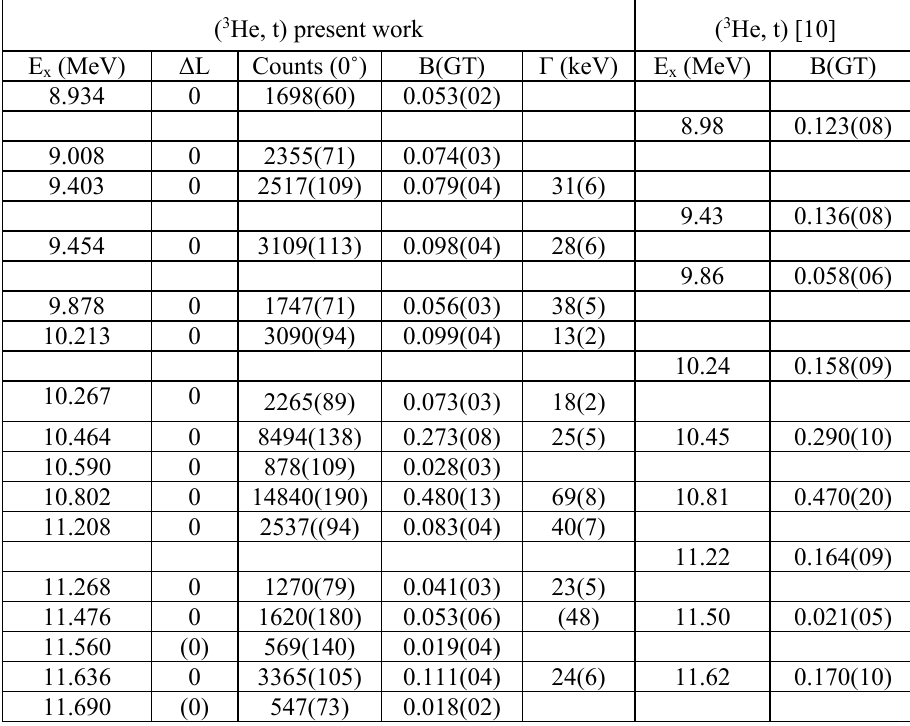
Table 2. States of 26 Al in the E x = 8.5-18.5 MeV region and GT transition strengths B(GT).